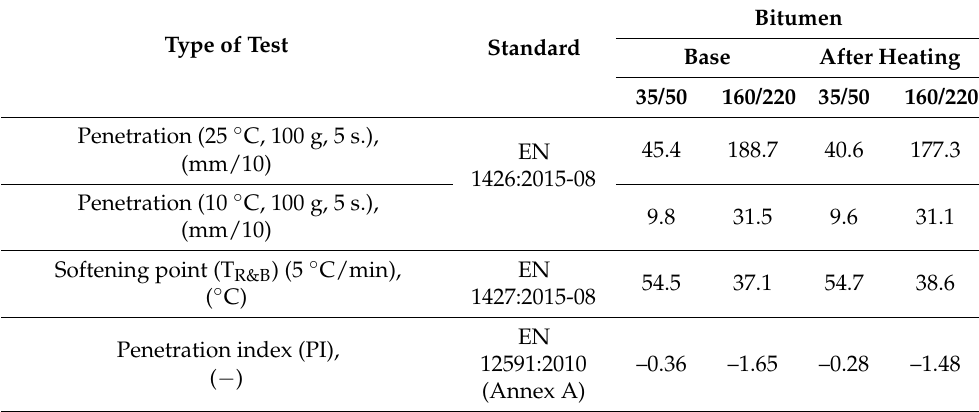
Table 5. Parameters of the bitumens used for the tests (base and after heating 180 ◦ C).